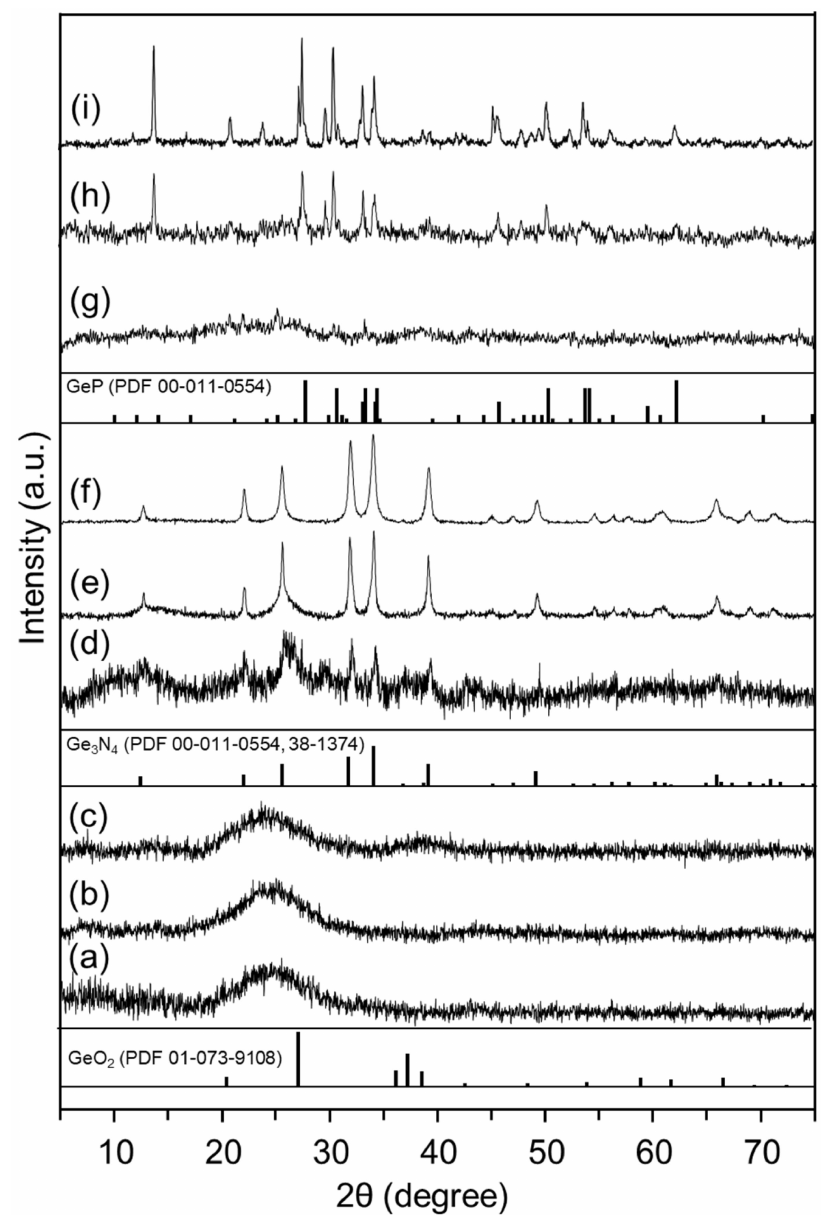
Figure 1. Powder X-ray diffractograms of GeO 2 -rGO-20 ( a ), GeO 2 -rGO-50 ( b ), GeO 2 -rGO-80 ( c ), Ge 3 N 4 -rGO-20 ( d ), Ge 3 N 4 -rGO-50 ( e ), Ge 3 N 4 -rGO-80 ( f ), GeP-rGO-20 ( g ), GeP-rGO-50 ( h ), and GeP- rGO-80 ( i ) powders. Vertical bars below represent the standard diffraction data for corresponding crystalline germanium